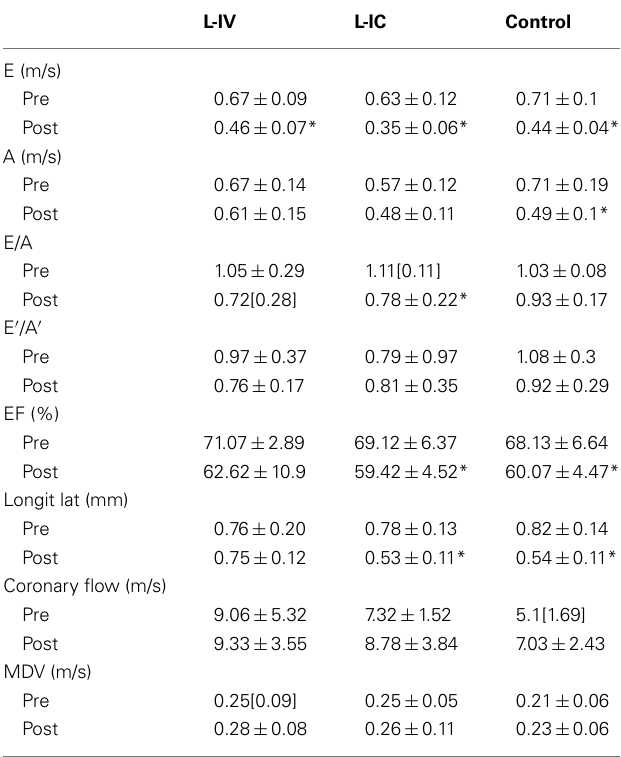
Table 1 | Echocardiography data at the beginning (pre) and at the end of the experiment